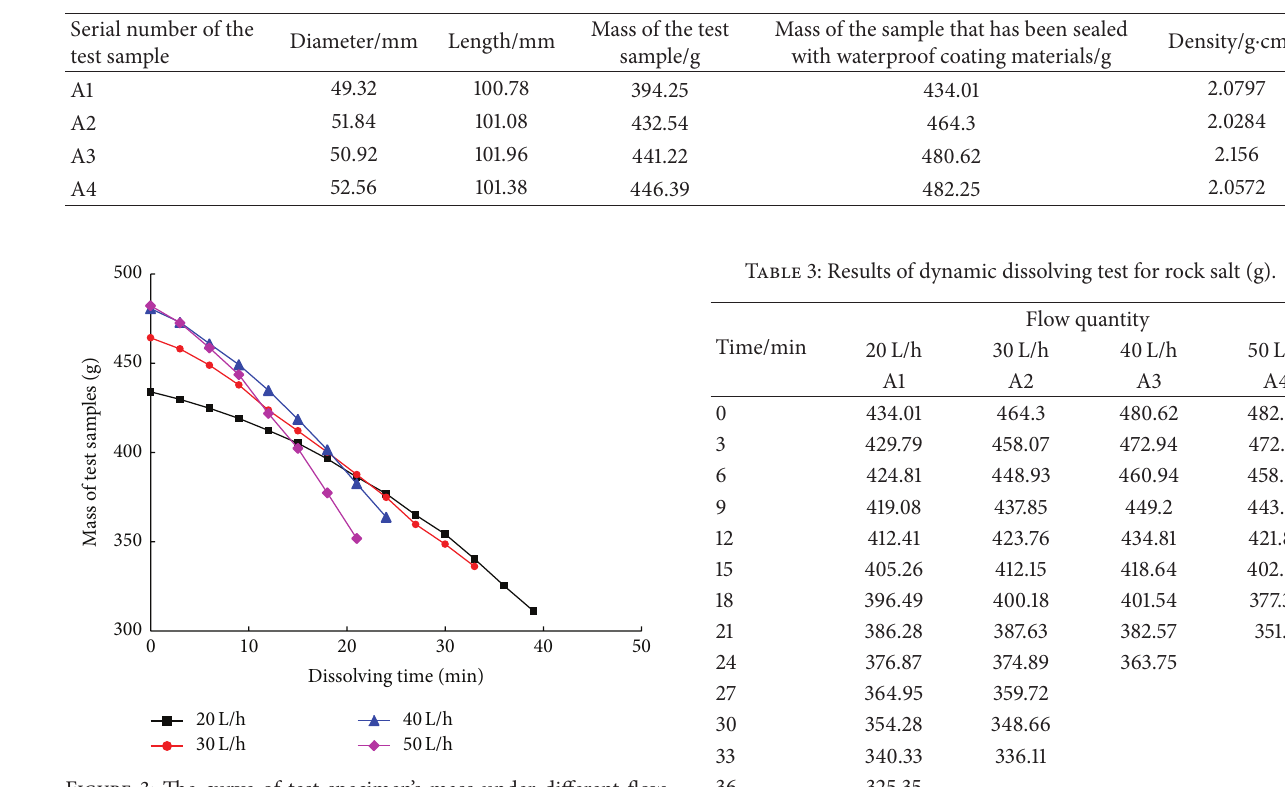
Table 2: Data of rock salt specimens.